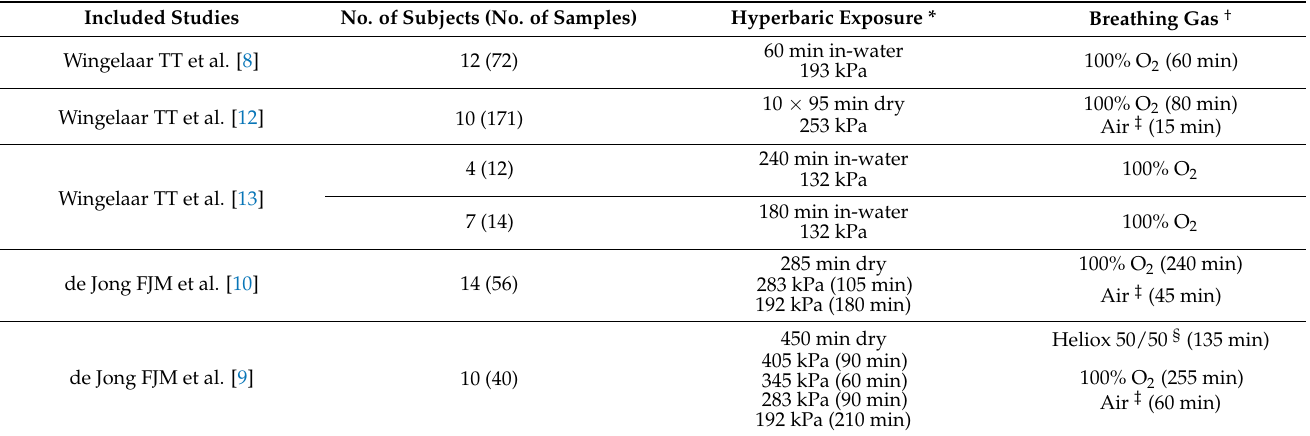
Table 4. Studies and their characteristics included in the VAPOR